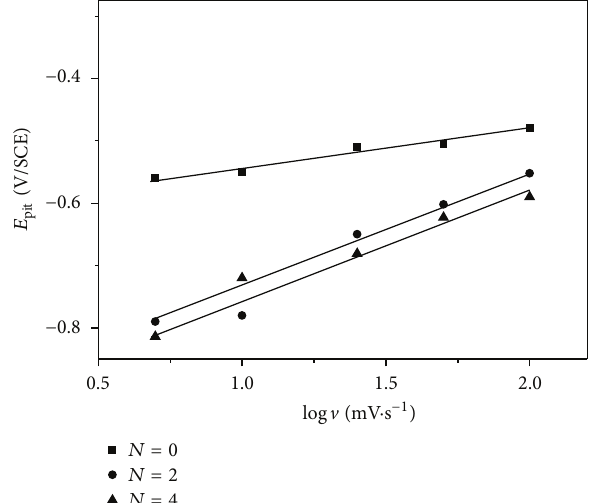
Figure 7: Dependence of 𝐸 on the logarithm of scan rate ( log V ) pit for the ECAP’ed ( 𝑁 = 2 and 4) and unpressed ( 𝑁 = 0 ) samples, obtained at 25 ∘ C in 3.5 wt.% NaCl solution at pH 6.4.